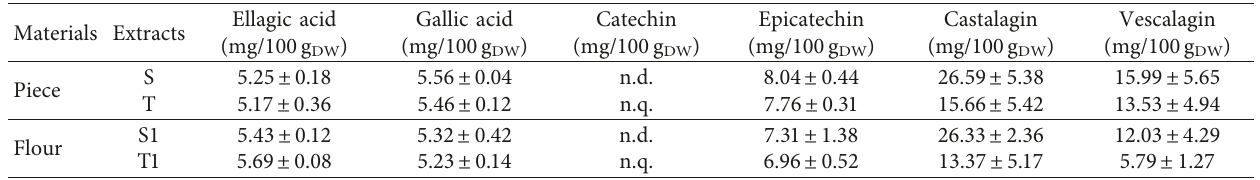
Table 3: Benzoic acid, catechin, and tannin composition of breadfruit